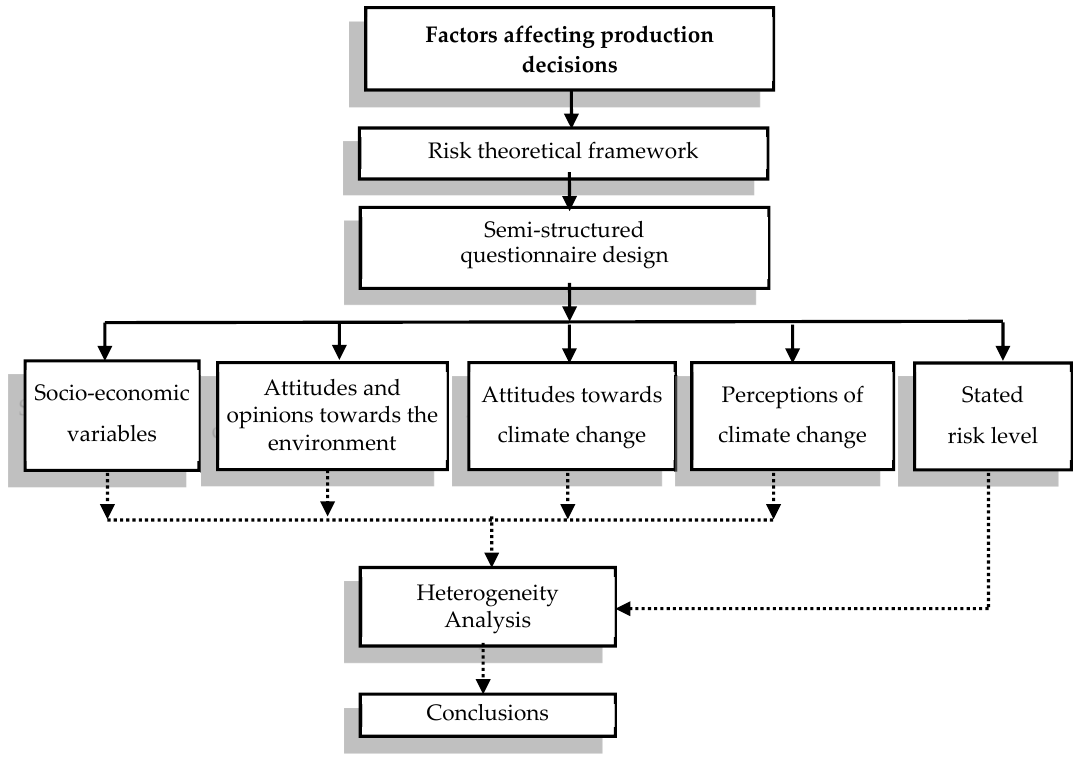
Figure 2. Methodological research approach.